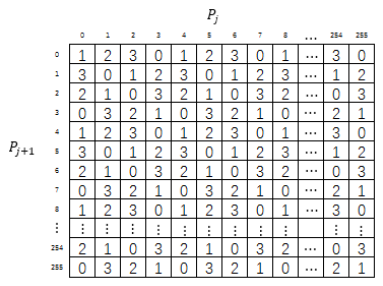
Figure 4. Mini-SuDoKu reference matrix.